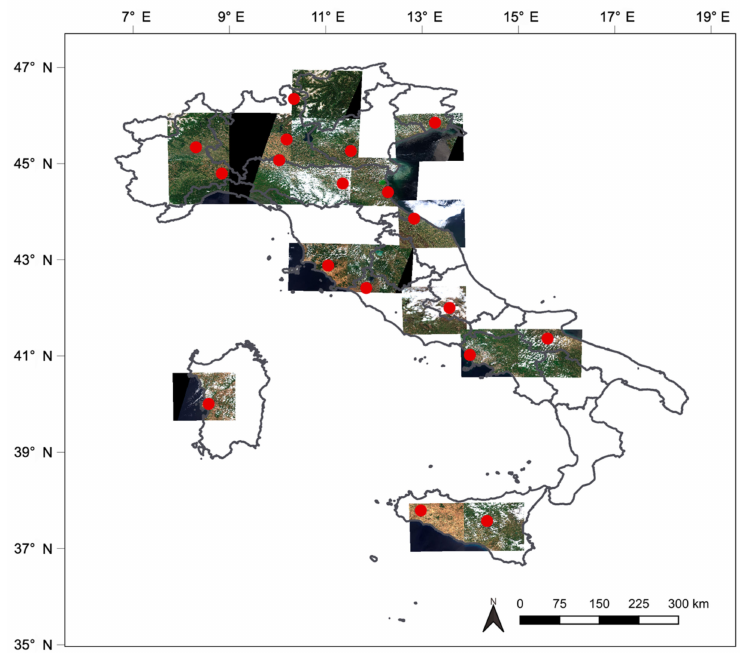
Figure 1. Study areas location (red dots) with samples of Sentinel2 scenes.